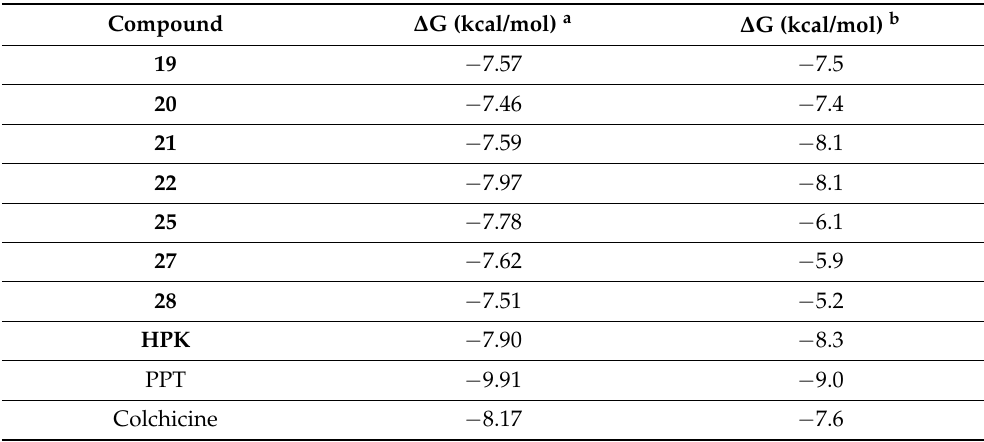
Figure 3. 4-Phenyl-2-quinolone (4-PQ) compounds, HPK , podophyllotoxin, and colchicine docked into αβ -tubulin (PDB ID: 1SA1) via AutoDock Vina. ( A ) 4-PQs (white lines), HPK (yellow lines), podophyllotoxin (blue spheres), and colchicine (pink spheres) bound to β -tubulin (cyan) at the interface with α -tubulin (green). ( B ) Podophyllotoxin’s co-crystallized pose (green) and docking pose (blue). ( C ) The co-crystallized pose (orange) of N-deacetyl-N-(2-mercaptoacetyl)-colchicine (DAMA-colchicine) and docking pose (pink) of colchicine. ( D ) All docked compounds were superimposed on each other. The white lines represent compounds 19 , 20 , 21 , 22 , 25 , 27, and 28 . The yellow lines represent HPK . The blue sticks represent podophyllotoxin, and the pink sticks represent colchicine. Table 4. The free binding energies (kcal/mol) of the synthesized 4-PQ compounds and reference drug against the colchicine-binding site of the tubulin